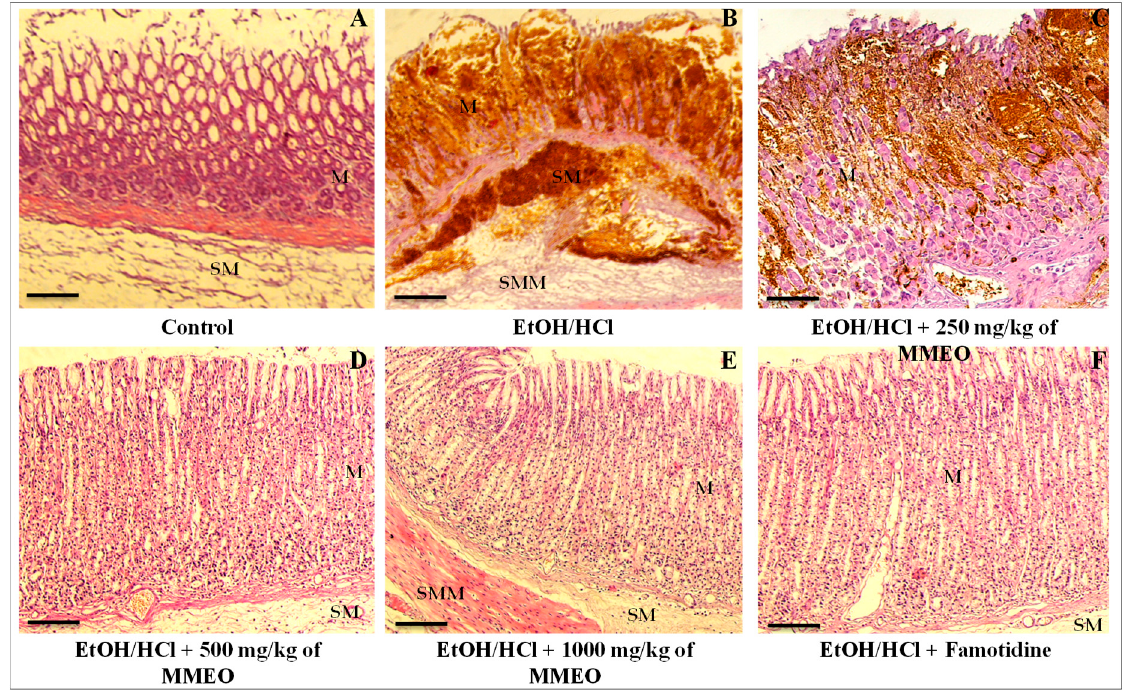
Figure 3. Histological findings of rat gastric mucosa. ( A ) stomach from control rat. ( B ) Stomach from rat treated with EtOH/HCl. Exacerbation of necrosis of surface mucus cells and glands, hemorrhage in mucosal layer and edema of submucosal layer were observed. ( C , D , E ): Stomach from rat treated with 250, 500 and 1000 mg/kg of MMEO, respectively + EtOH/HCl. Dose dependent reduced injuries were observed. (F): Rat treated with 20 mg/Kg of famotidine + EtOH/HCl. No obvious injuries are recognized in mucosal layer. Bar: 100 µm. M: mucosal layer; SM: submucosal layer. Compared with the control group, gastric lesions produced by EtOH/HCl resulted in To further understand the contribution of MMEO constituents on the EO gastroprotec- inflammation of the mucosa and the formation of several ulcers (ulcer index, UI = 2.66) tive abilities, the direct relation between the protection, healing, and ulceration percentage and hemorrhagic furrows (% of ulceration = 85.16%) concomitant with a decrease in with the concentration of the involved volatile components in MMEO and Pearson’s cor- gastric juice volume from 4.26 to 1.75 mL, and of pH from 5.09 to 2.04 (Table 2). In turn, relation coefficients analysis were evaluated (Figure 4 and Table 3, respectively). the oral pre-treatment with 250, 500 and 1000 mg/kg of MMEO ameliorated the gastric parameters, including re-establishment of mucosa, gastric pH and volume. In particular, administration of a high MMEO dose (1000 mg/kg, p < 0.001) set the index and the percentage of ulceration respectively at 1.63 and 19.66% and conferred a percentage of protection (PP) and healing (HP) of 83.33% and 69.97%, respectively, plus a sharp restoring of acidity and pH. This is consistent with previous reports demonstrating the gastroprotective and ulcer healing properties of EOs through reduced gastric volume and acidity, decreased lipid peroxidation, and increased mucus production [13,32]. Table 2. Effect of oral pre-treatment with microencapsulated myrtle essential oil (MMEO) on gastric ulcer parameters in rats ( n = 6/group). Group 1 (Normal Control)